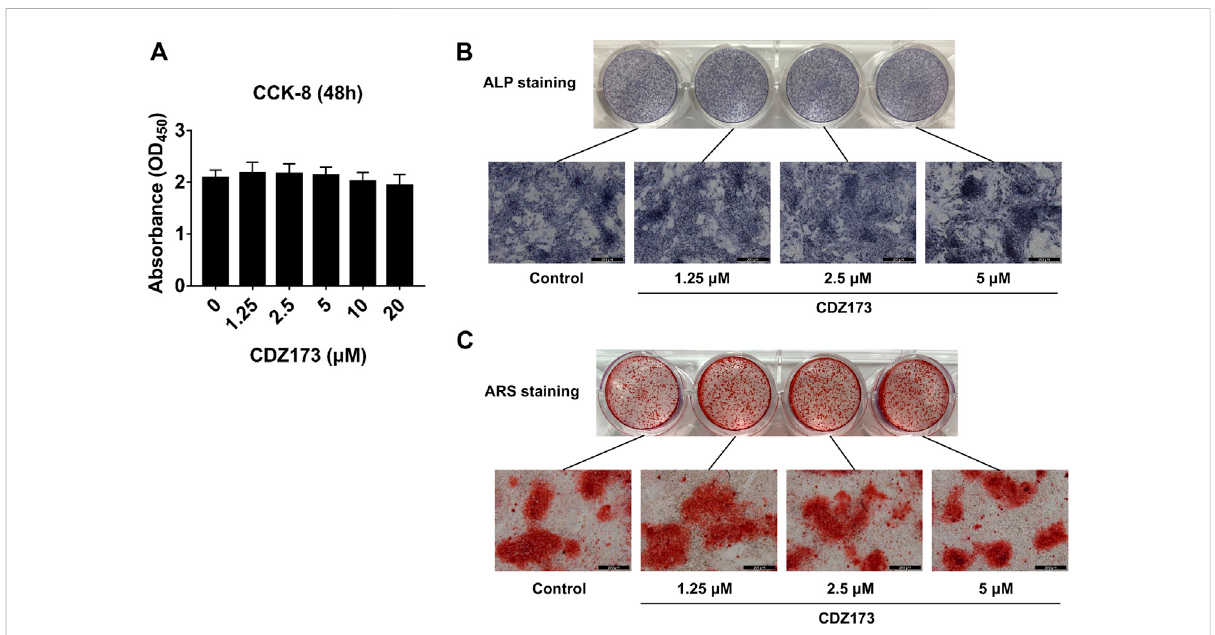
CDZ173 did not affect the differentiation and mineralization of osteoblasts. (A) For 48 h, BMSCs were exposed to the stated doses of CDZ173 before being evaluated using CCK-8 assays. (B) ALP staining in the absence or presence of CDZ173 (1.25, 2.5, and 5 μ M) for 7 days (scale bar = 200 µM). (C) Alizarin Red S in the absence or presence of CDZ173 (1.25, 2.5, and 5 μ M) for 21 days (scale bar = 200